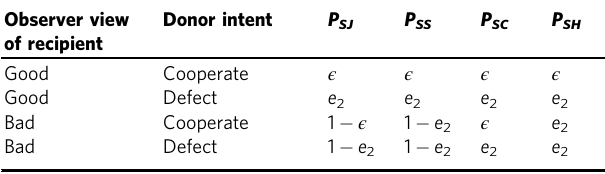
Table 1 Probability P k that an observer will assign a donor a good reputation, under each of four social norms k ∈ [stern judging, simple standing, scoring,